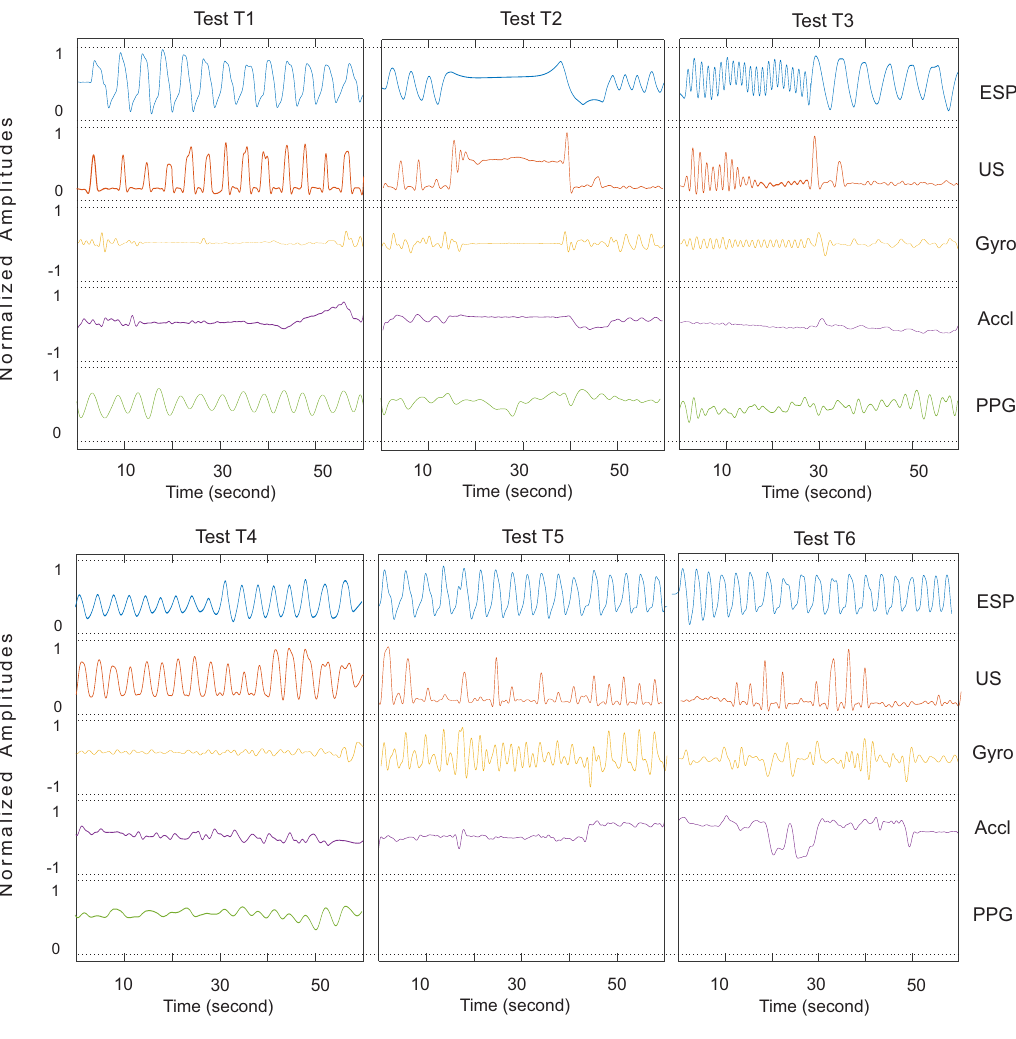
Figure A1. Respiratory waveforms of Subject